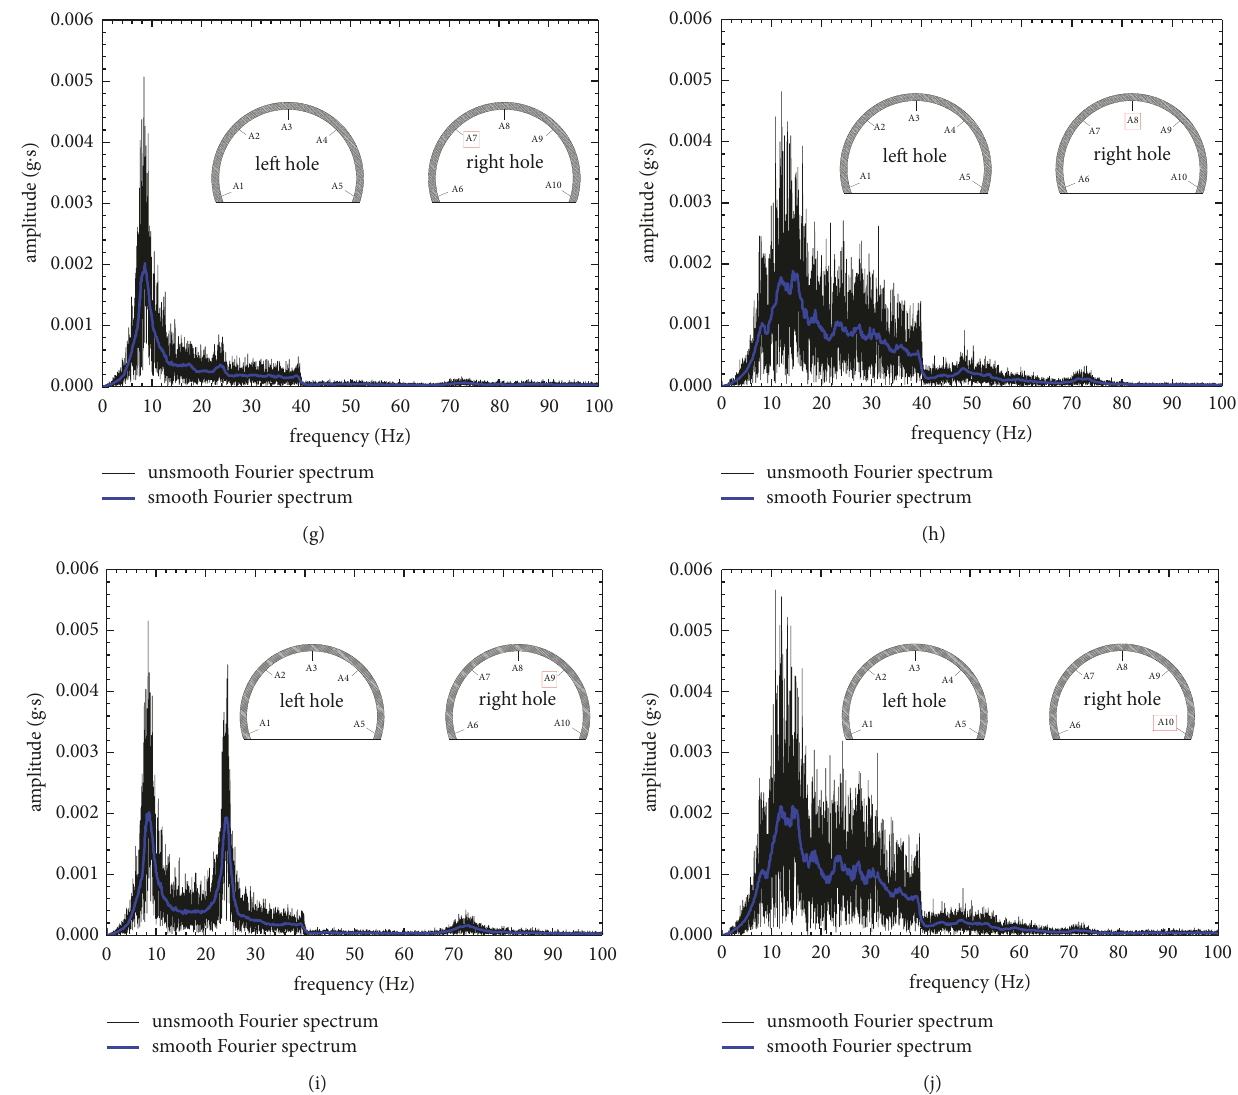
Figure 6: Fourier spectra of different measuring points: (a) measuring point A1; (b) measuring point A2; (c) measuring point A3; (d) measuring point A4; (e) measuring point A5; (f) measuring point A6; (g) measuring point A7; (h) measuring point A8; (i) measuring point A9; (j) measuring point